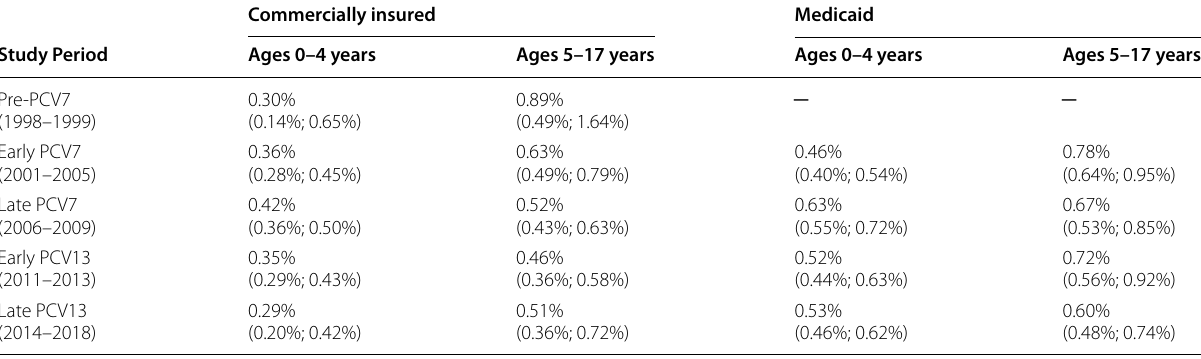
Table 6 Inpatient CFR and 95% CIs by age group for commercially and Medicaid‑ insured children aged < 18 years with ACP, by age group